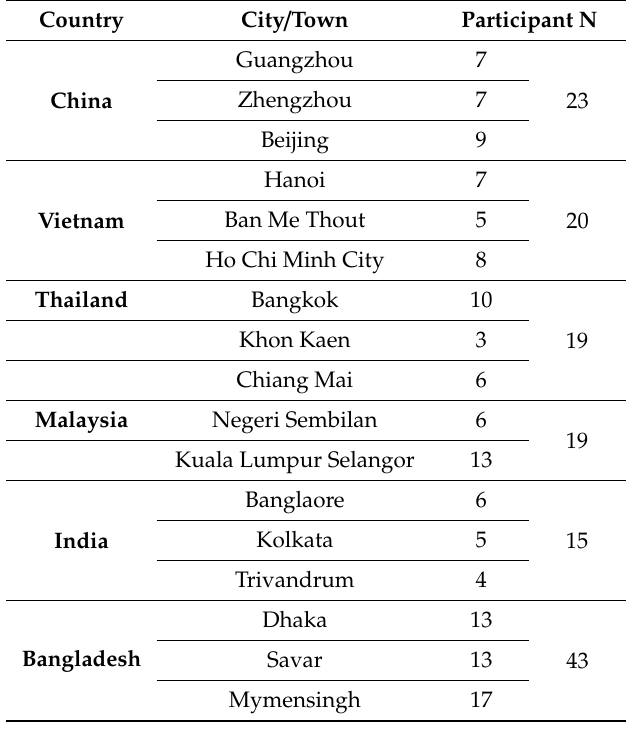
Table 1. Participants by